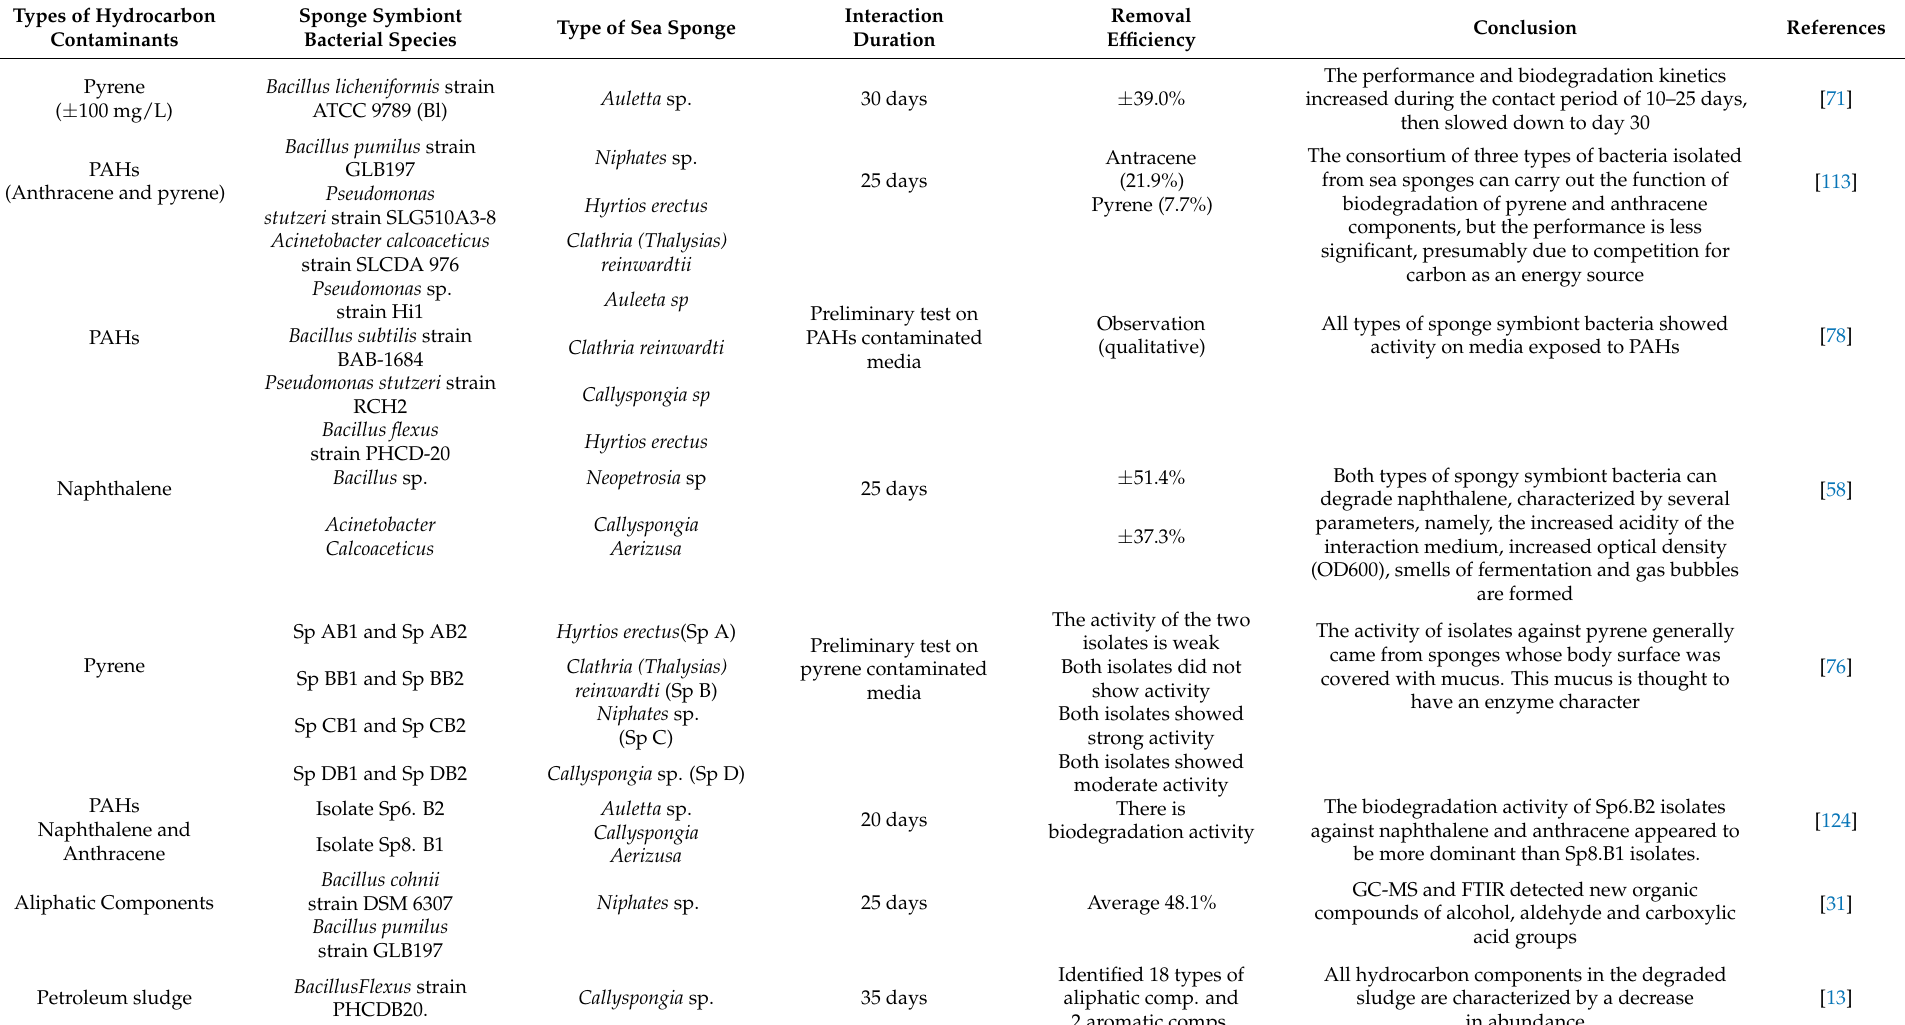
Table 2. Various studies on the biodegradation performance of sponge symbiont bacteria on hydrocarbon